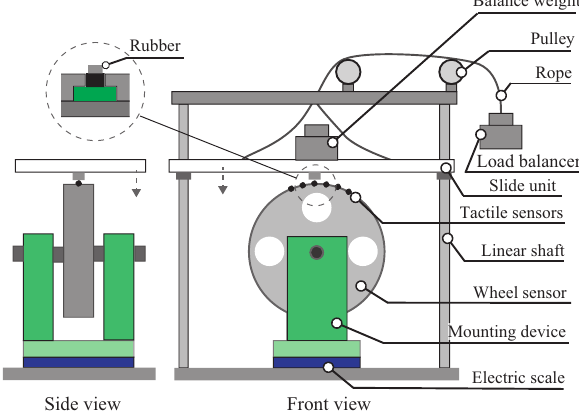
Figure 7. Calibration test setup. The rubber mounted on the slide unit acted perpendicularly on each tactile sensor. The rubber’s area was smaller than the contact area of the sensor. The load balancer offset the weight of the slide unit, and the balance weight was loaded on the slide unit. The mounting device adjusted the rotation angle of the wheel and each sensor was tested. The electric scale measured actual weight, and measured values were compared to each sensor